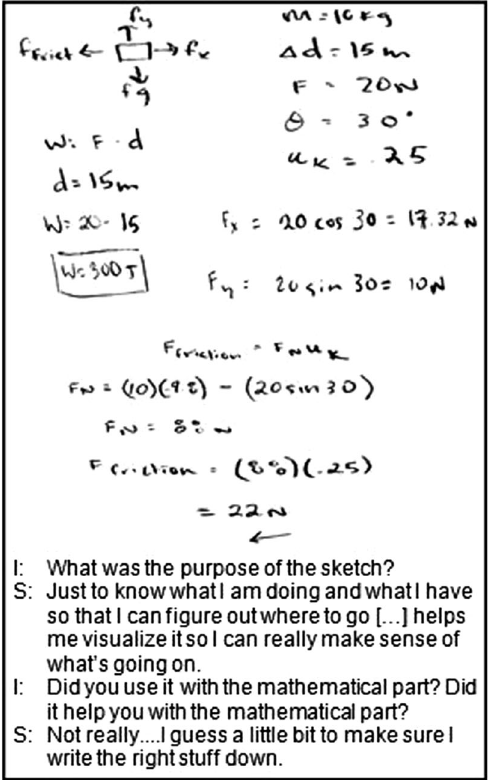
FIG. 17. Solvevaluefromgraphicalrepresentations(question10). FIG. 18. Solve value from linguistic representation (question